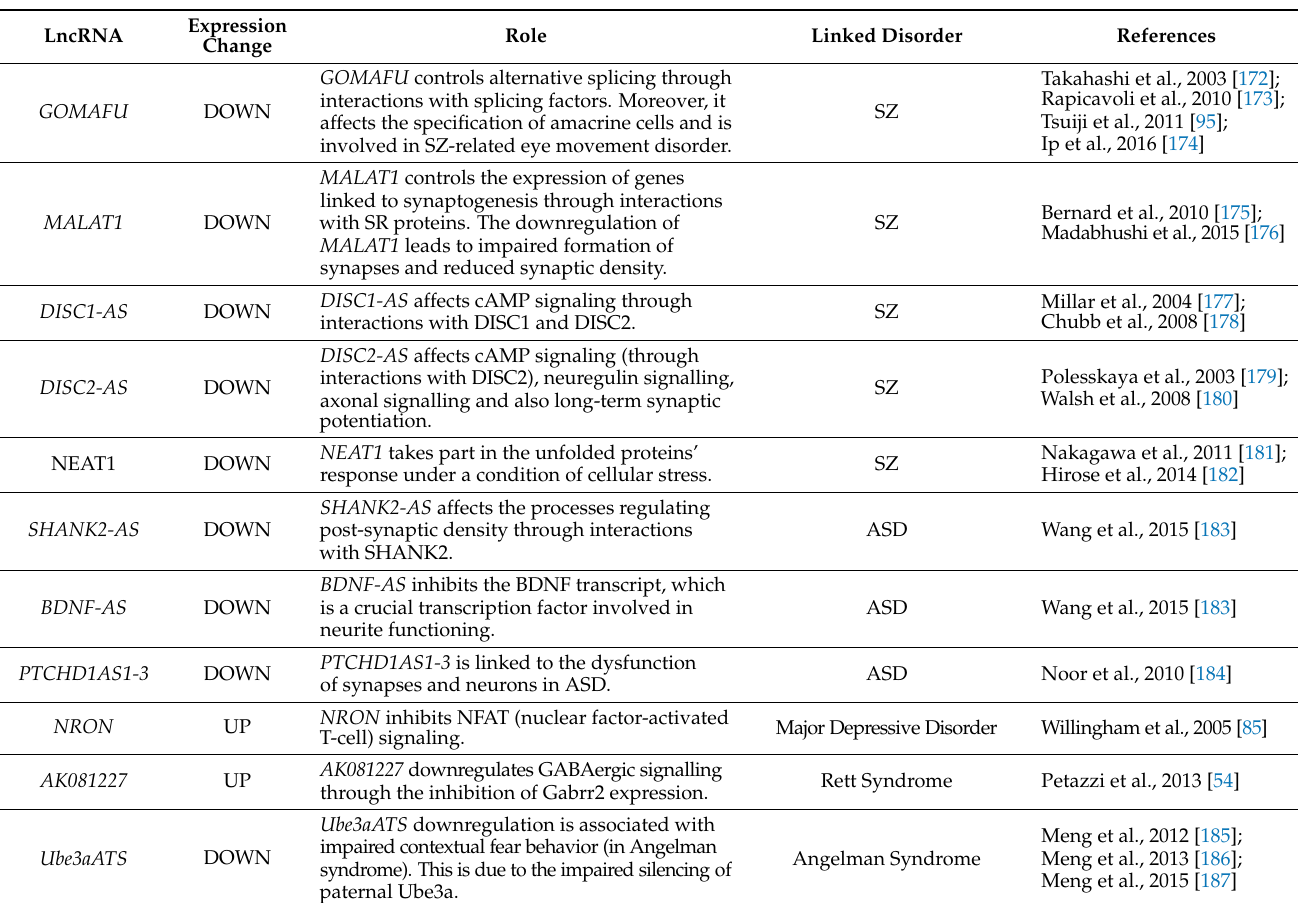
Table 2. LncRNAs dysregulated in neurodevelopmental and neuropsychiatric disorders. The chosen examples of lncRNAs are involved in neurodevelopmental and neuropsychiatric disorders. (UP: upregulation; DOWN: downregulation; references are